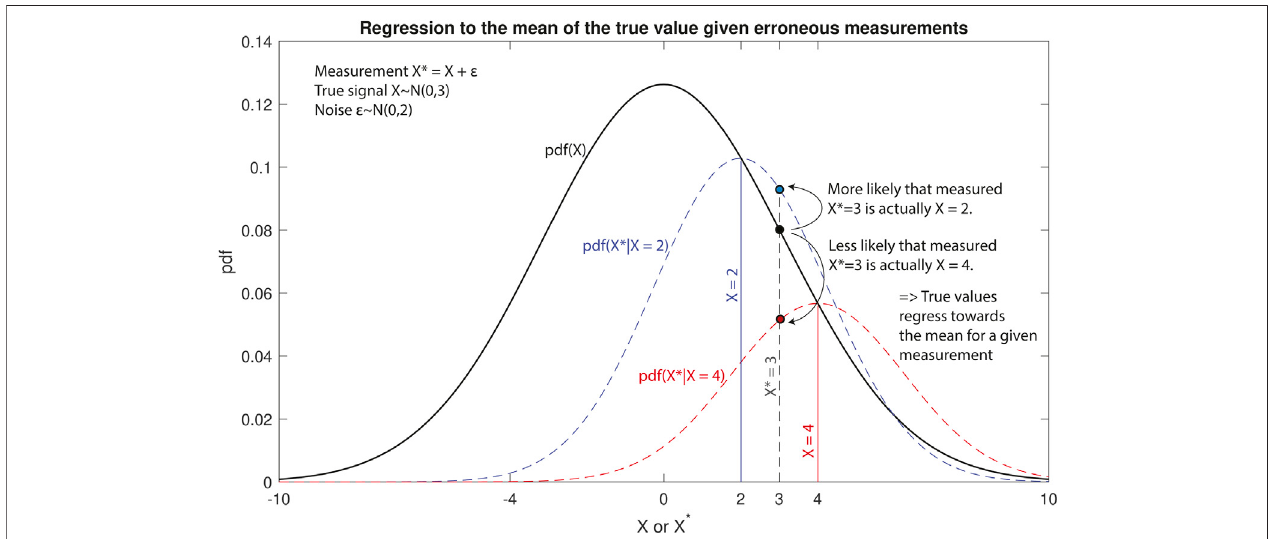
FIGURE 2 | Demonstrating regression to the mean of the true value of an erroneous measurement. The black line is the underlying probability distribution of a randomvariable X .Anerroneousmeasurementof X is X *= X + ϵ ,where ϵ isuncorrelated Gaussiannoise.Onesuchmeasurement, X *=3,isrepresented using theblack dashed line. The likelihood that the true value X is also 3 is represented by the black fi lled circle on pdf ( X ). The blue dashed line is the conditional probability density function pdf ( X *| X =2),anditintersectsline X *=3 attheblue- fi lledcircle,whichrepresentsthelikelihoodthatthetruevalue X is2.Similarly,thereddashedlineisthe pdfX * | X (cid:2) 4, which intersects line X * = 3 at the red- fi lled circle, which represents the likelihood that the true value X is 4 given the measurement X * = 3. From the relative positions of the circles, we can conclude that it is more likely for the true value to be closer to the mean value of X than X = 3 or 4 or